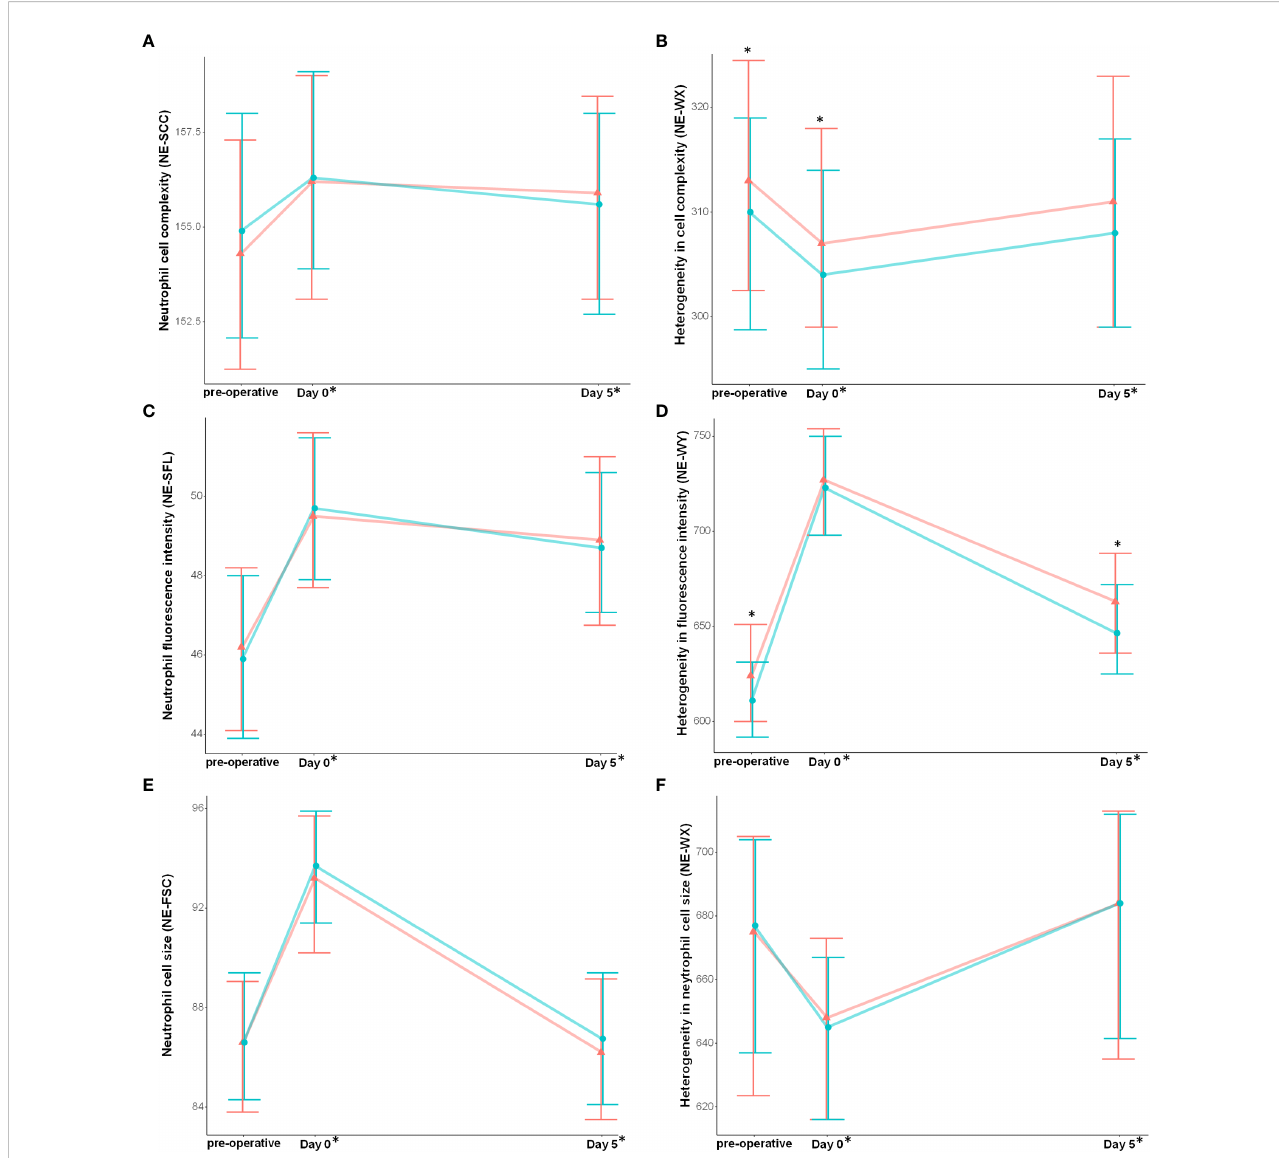
FIGURE 4 Neutrophil cell populations data are modi fi ed with cardiac surgery and are associated with post-operative complications. (A) Neutrophil cell complexity, (B) Heterogeneity in cell complexity, (C) Neutrophil fl uorescence intensity, (D) Heterogeneity in fl uorescence intensity, (E) Neutrophil cell size, (F) Heterogeneity in neutrophil cell size. Results are presented as median and interquartile range. * above the plot refers between groups signi fi cant difference (non-parametric test, p-value were corrected using Bonferroni ’ s method). * on the x-axis report signi fi cant differences from baseline (intragroup comparison with p < 0.05). Red represent patient that developed the composite complication criteria and blue patient who did not.